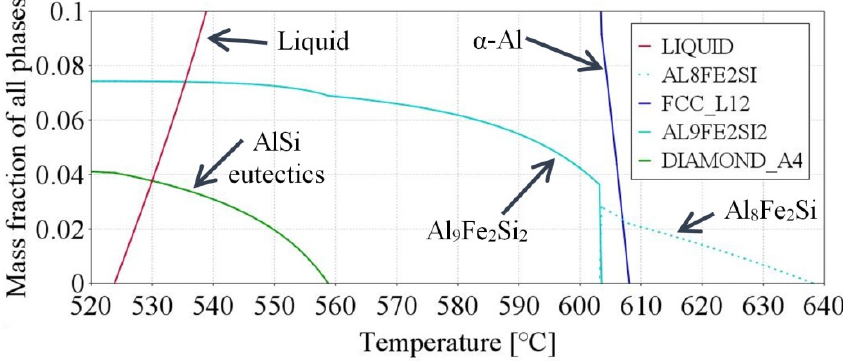
Figure 14. Property diagram for the AlCu4Si6Fe2.0 alloy.